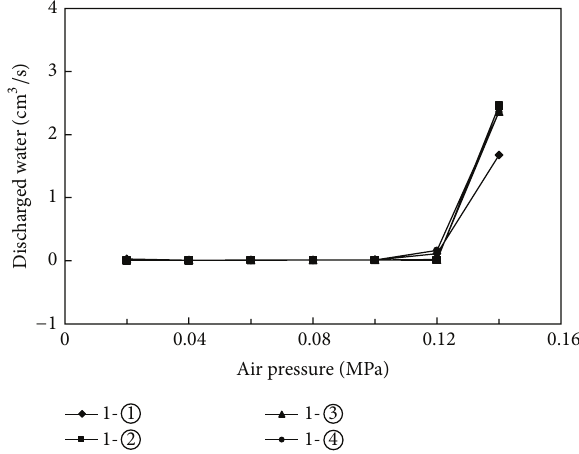
Figure 3: Relationship between discharged water and air pressure of filter cake